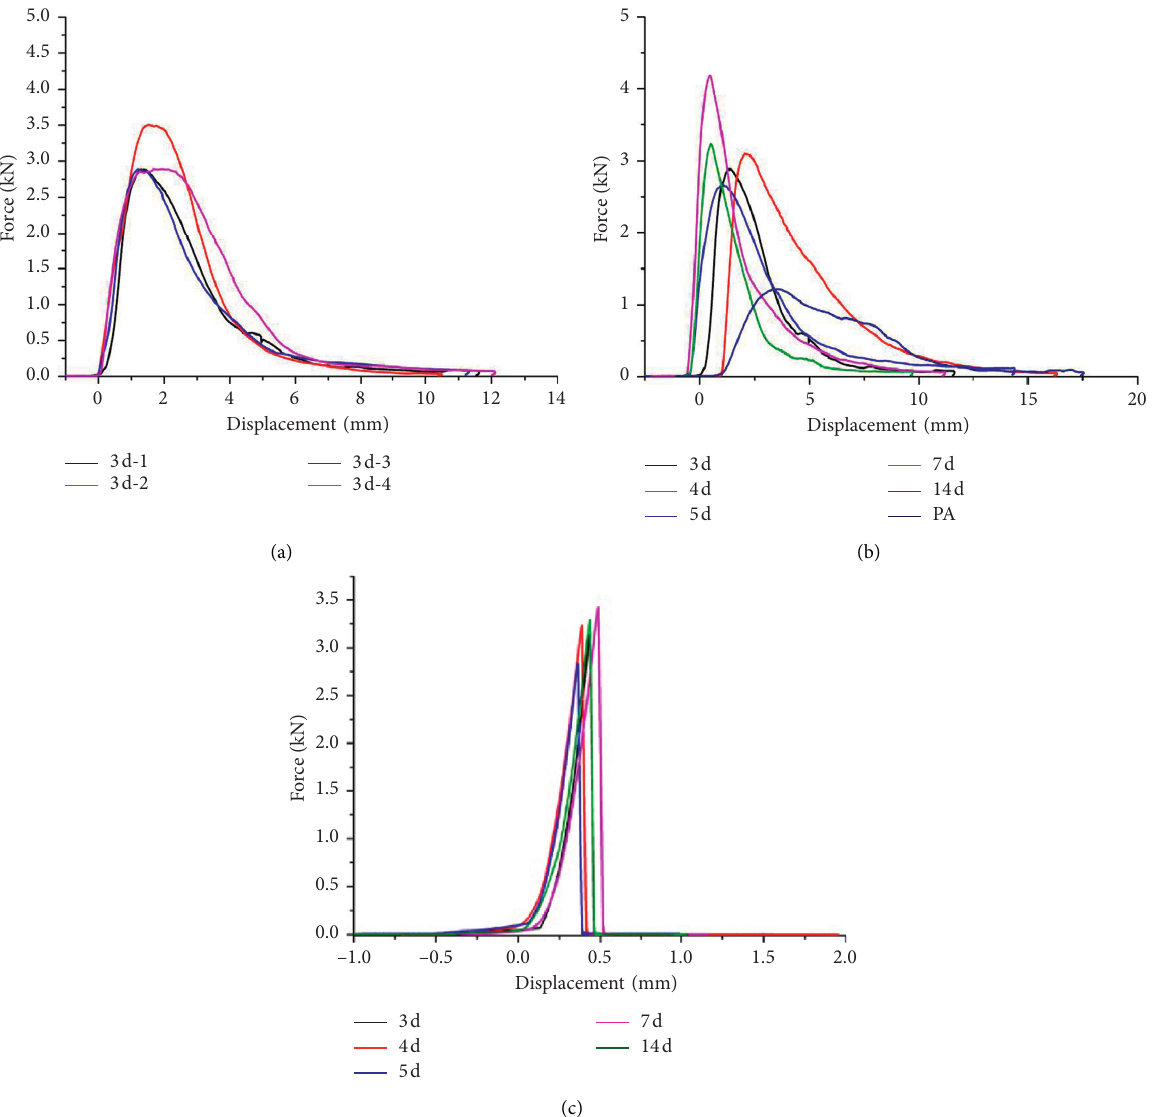
Figure 9: Force-displacement of SFP sample and PA sample. (a) 3 days’ cured SFP samples. (b) SFP samples and PA sample. (c) Grouting materials with different curing days.